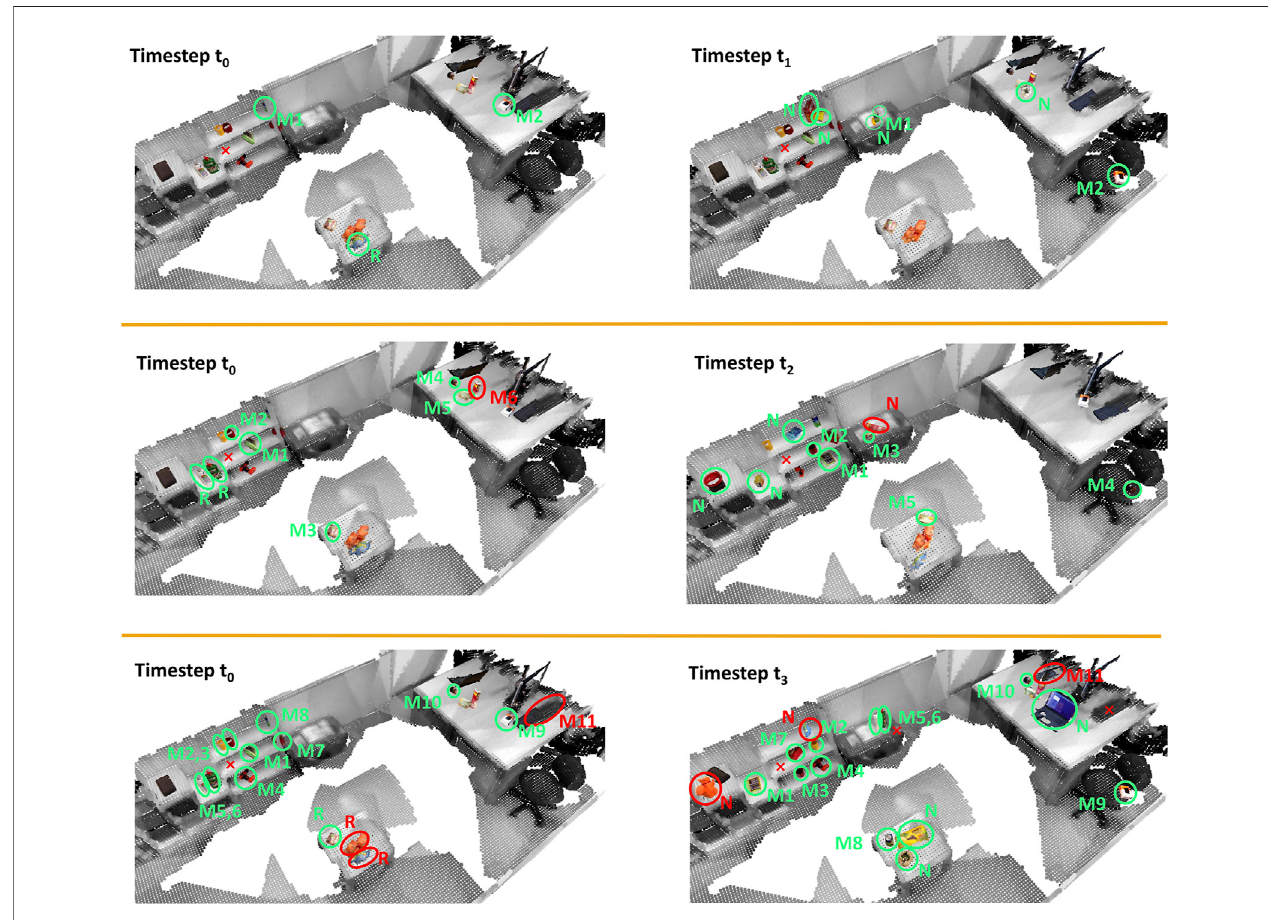
FIGURE 7 | Results of real-world robot experiments. Each row shows the comparison of the reference room ( fi rst column) with the state of the same room at a differenttime(secondcolumn).EachdetectedobjectismarkedwithanellipseandlabeledwithM(moved),R(removed),orN(novel).Correctcategorizationsarecolored in green, wrong ones in red.Objects, which werematched, have thesamenumber assigned.Forsimplicitystatic objects are notshown and missed objectsaremarked with a red cross.